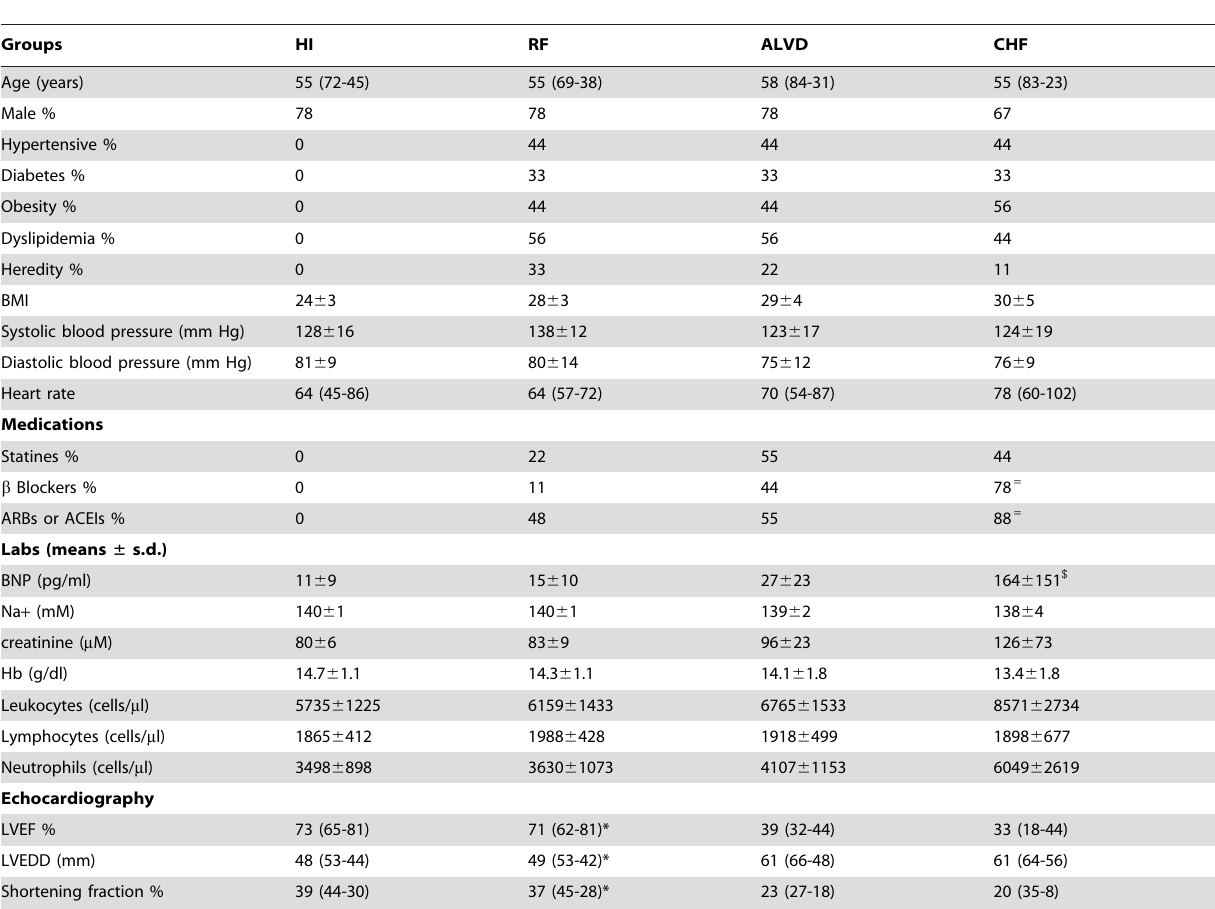
Table 1. Cardiovascular risk factors, clinical and biochemical parameters of study